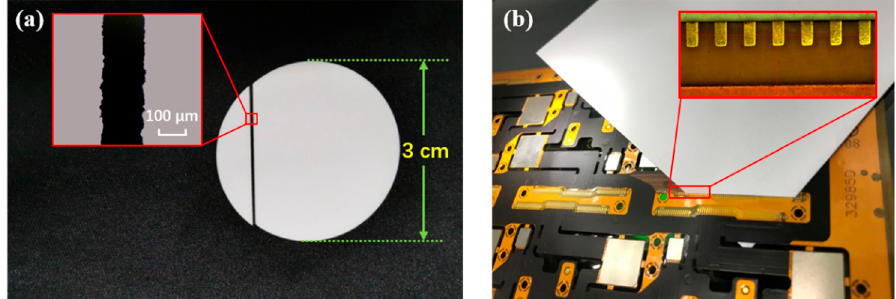
Figure 3. Experiment result of femtosecond laser processing of ( a ) alumina ceramic with 0.2 mm thickness, and ( b ) FPC with 0.11 mm thickness.